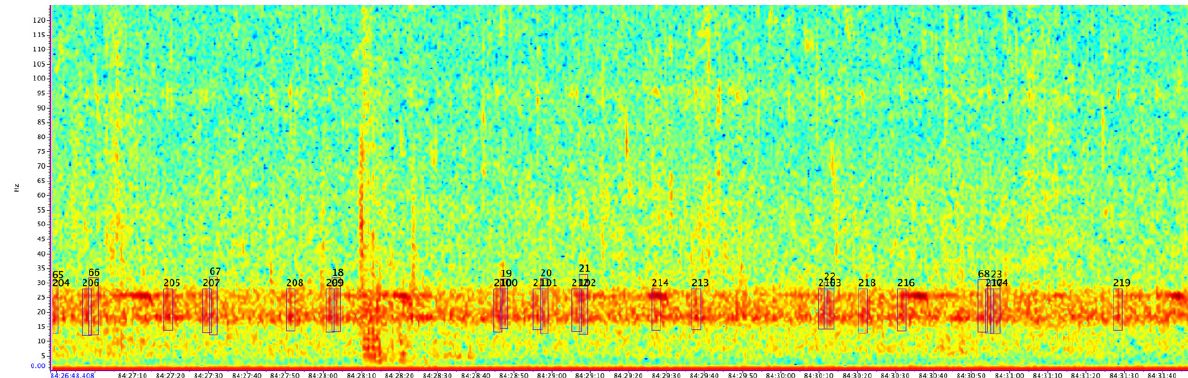
Figure A5. F20P log examples from file 20170510_090000 for the location Casey.